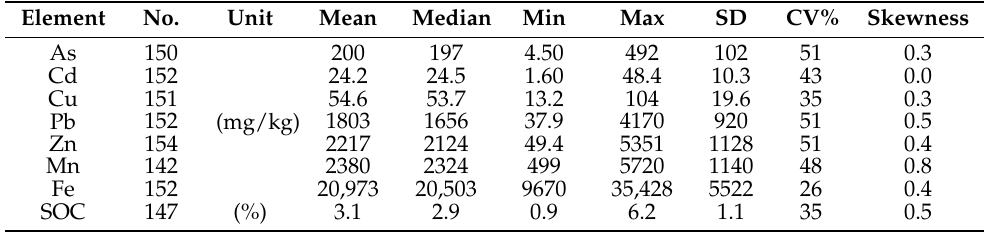
Table 1. Statistical description of measured pseudo-total content of potentially toxic elements (PTEs), total Fe, and soil organic carbon (SOC).